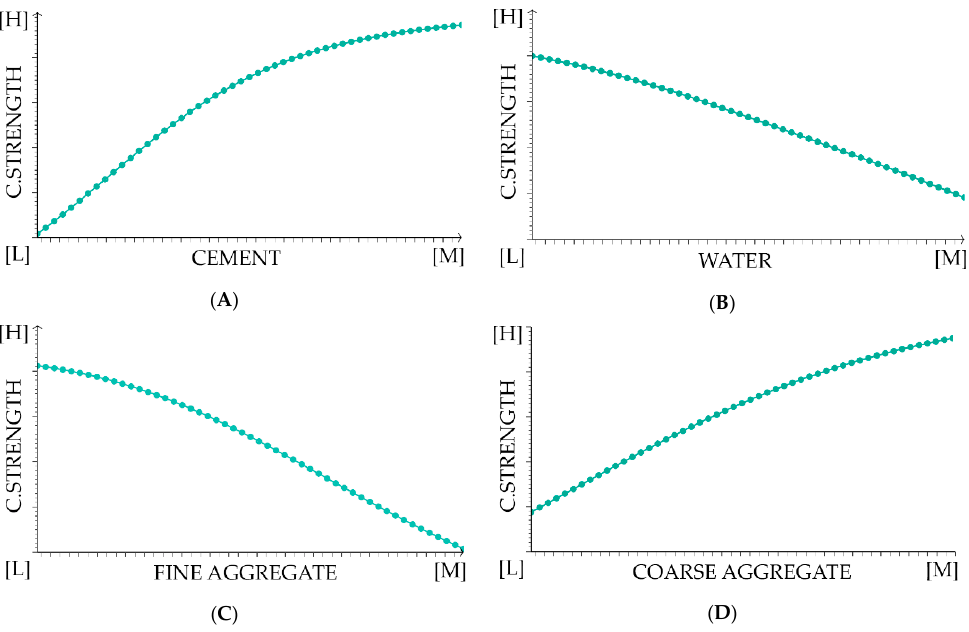
Figure 7. Output charts. The diagrams show variations in output variables for a single input variable, while the others are fixed. The vertical axis is the full compressive strength of concrete. The horizontal axis is the amount of material. ( A ) Cement; ( B ) water; ( C ) fine aggregate (sand 0–2 mm); ( D ) coarse aggregate (aggregate above 2 mm); [H], [M]—Higher/More; [L]—Lower/Less.